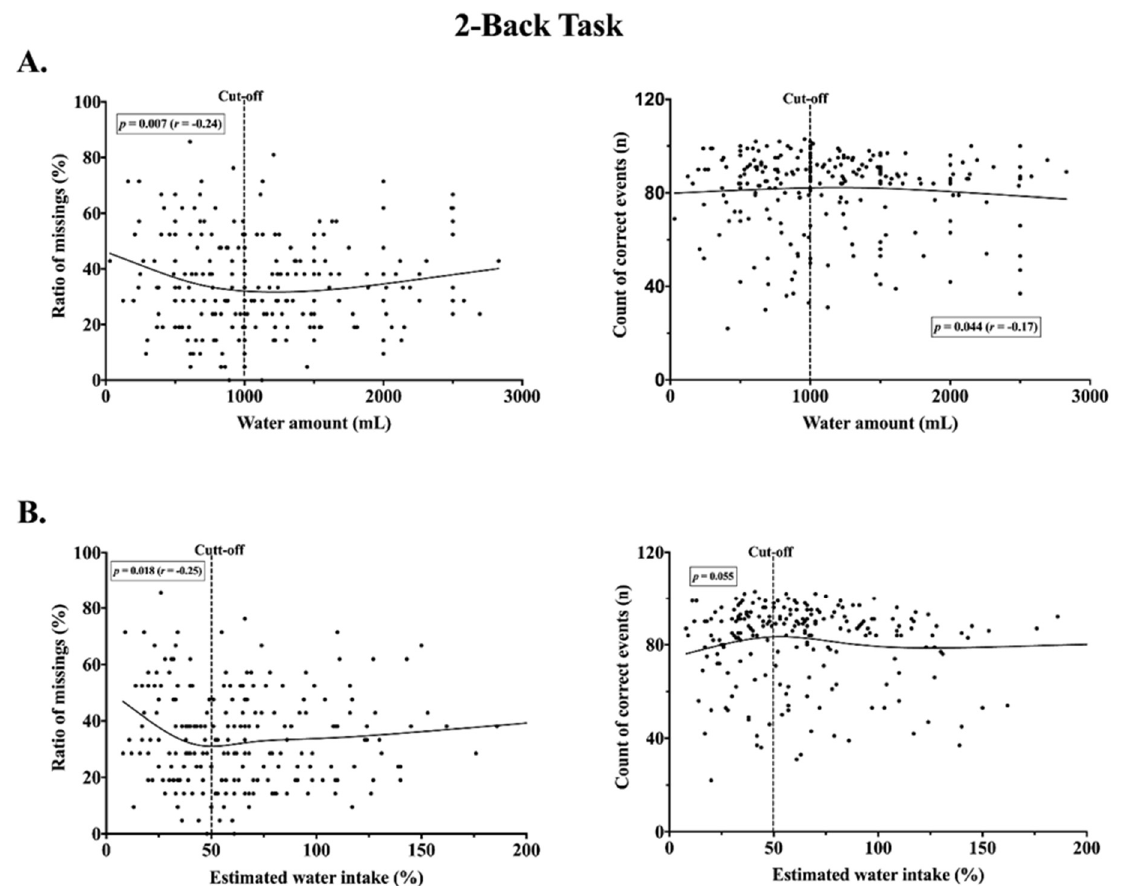
Figure 5. Scatterplots of a relationship between water intake during a school day and cognitive performance in the 2-back task. ( A ) Non-linear negative association for ratio of missings and water amount below cut-o ff ( n = 107). Non-linear positive association for correct events and water amount over cut-o ff ( n = 107) ( B ). Non-linear negative association for ratio of missings and percentage of estimated water intake below cut-o ff ( n = 90). No association for correct events and percentage of estimated water intake below cut-o ff ( n = 90).